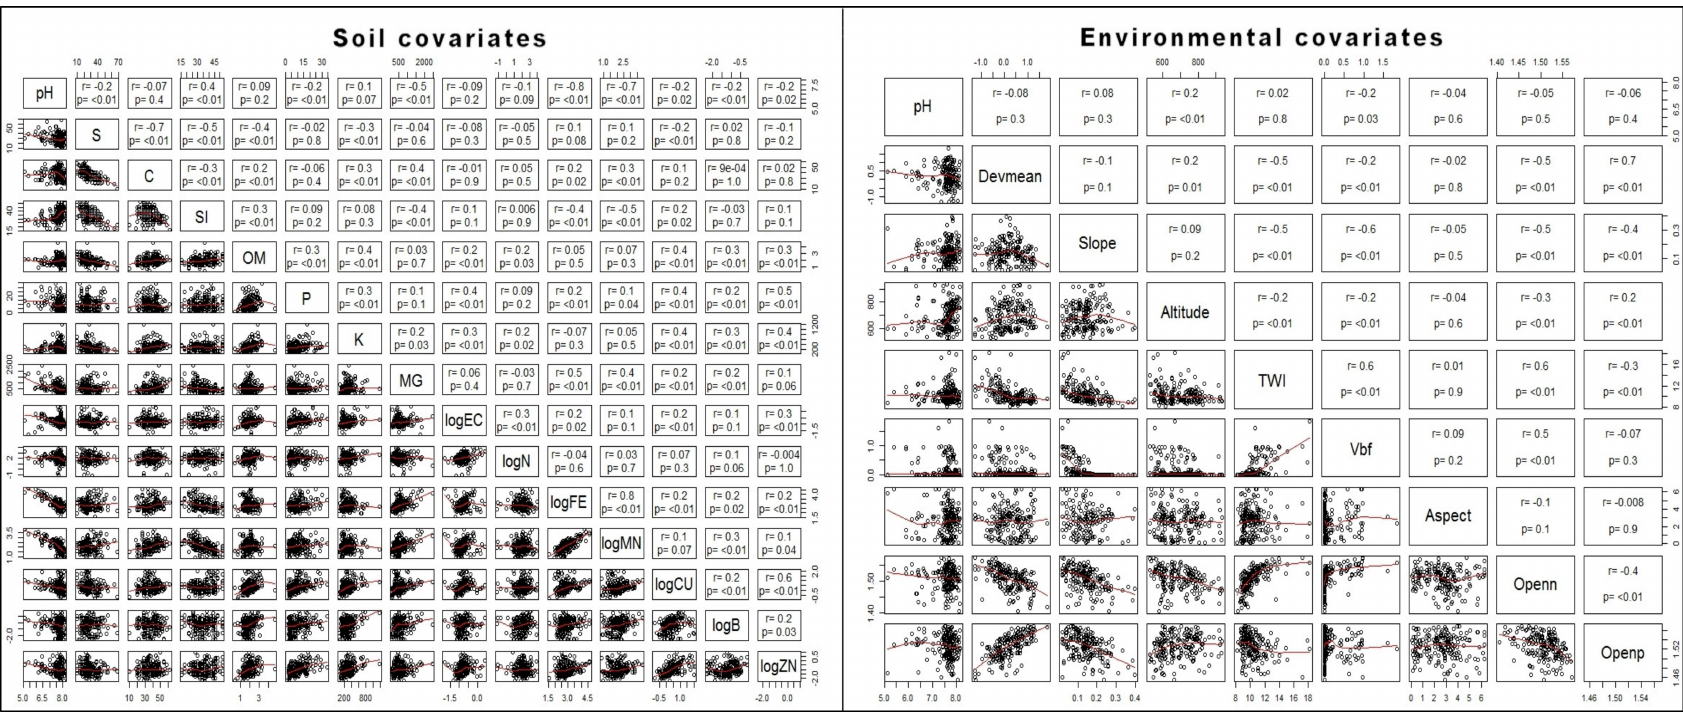
Figure 3. Pearson correlation analysis of